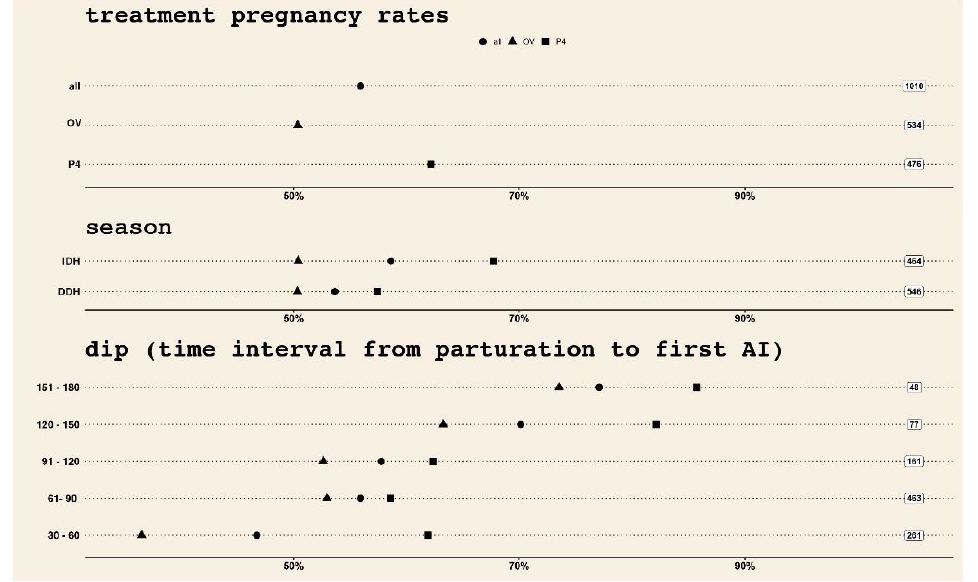
Figure 2. From top to bottom: overall pregnancy rate (circle), OV (triangle) and progesterone (square) pregnancy rates with regard to (i) treatment (top panel), (ii) season in which the insemination took place (middle panel), and (iii) dip, interval from parturition to first AI (bottom panel). Pregnancy rates refer only to the first AI after parturition. Table 1. In rows, descriptive statistics relative to the efficiency of the first AI recorded on primiparous buffaloes synchronized by Ovsynch (OV) or Progesterone based treatment (P 4 ), and in columns, undergoing AI during periods characterized by Increasing Daylight Hours (IDH) and Decreasing Daylight Hours